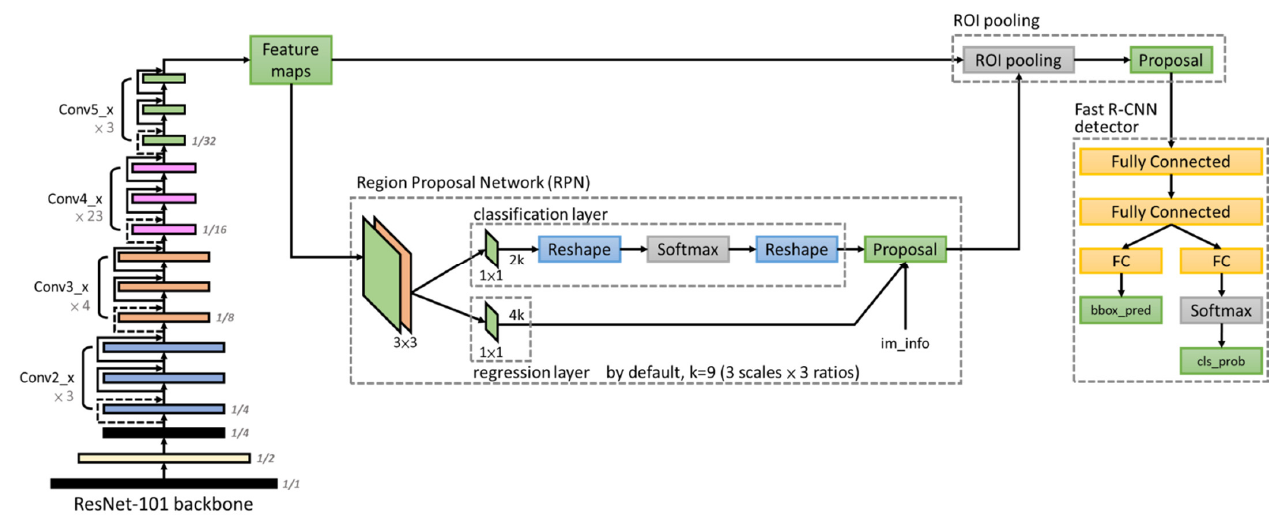
Figure 8. Architecture of Faster R-CNN ResNet-101.